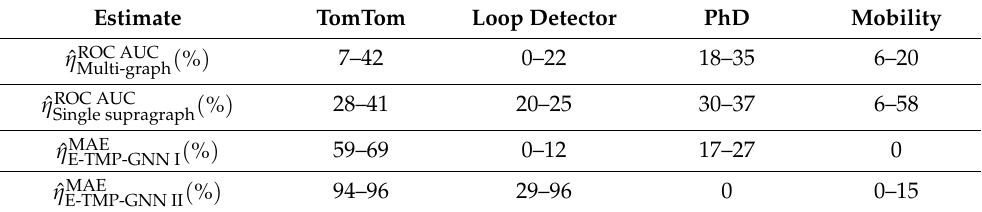
Table 2. Performance Comparison of E-TMP-GNN I, E-TMP-GNN II vs. counterpart